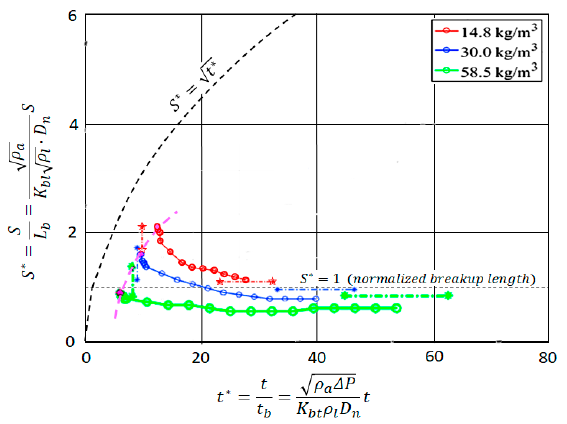
Figure 35. Non-dimensional expression of flame set-off (lift-off) positions corresponding to Figure 34.